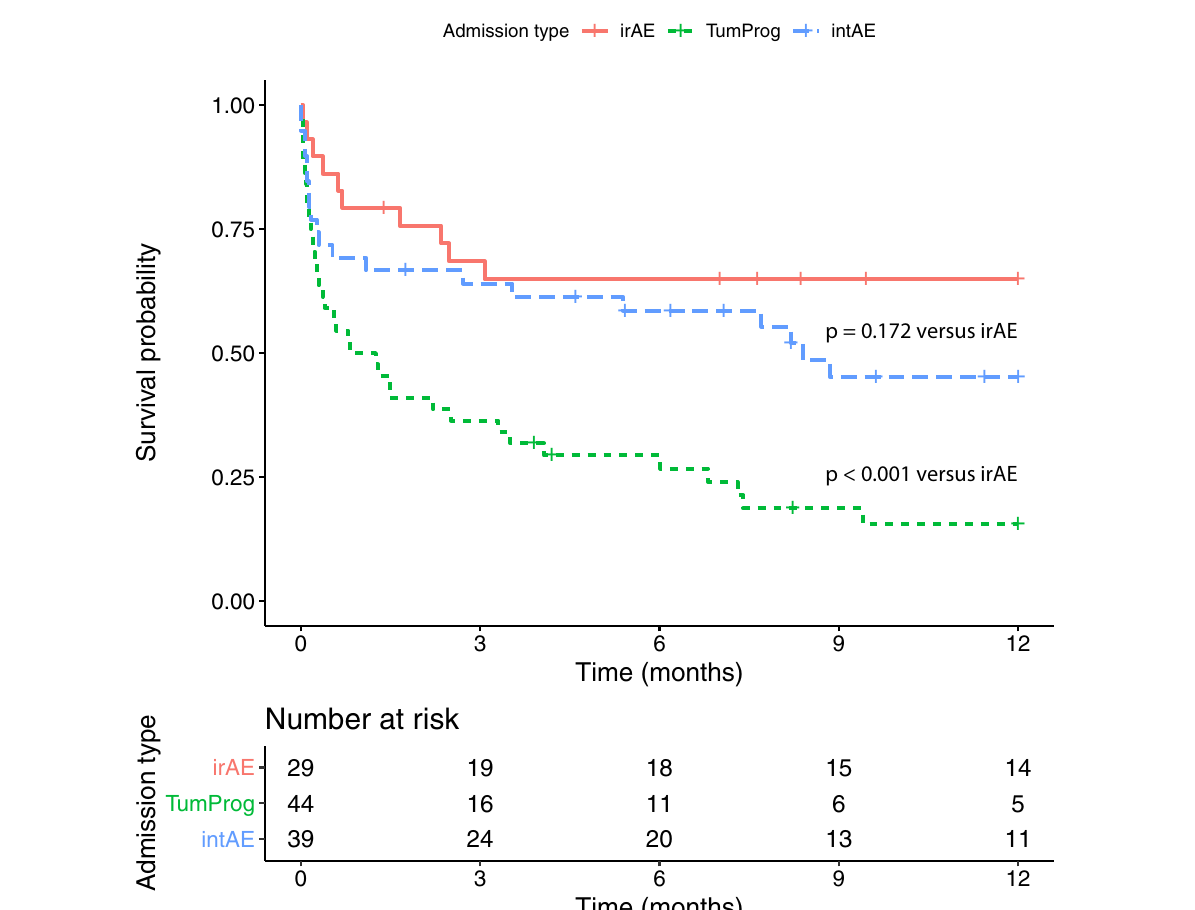
Fig. 3 Kaplan–Meier curves for overall survival of patients admitted for irAE compared to intE ( p versus others p 0.004). irAE immune‑related adverse event, TumProg complication related to tumor progression, intE intercurrent =